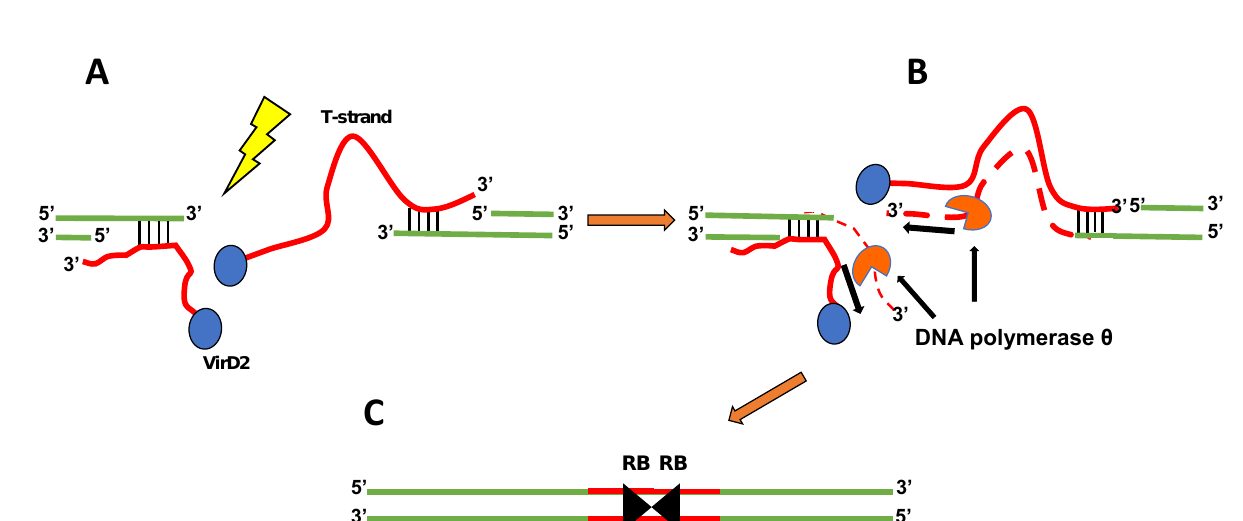
Figure 1. Model for the involvement of DNA polymerase θ in T-DNA integration. ( A ) Following generation of a double- strand DNA break (lightning bolt), the 5′ ends of plant DNA (green lines) are resected. Sequences within single-strand T- DNA molecules (T-strands, red lines), capped with VirD2 protein (blue oval) at their 5′ ends, align by microhomology with complementary regions of the exposed single-strand plant DNA. This can occur at both sides of the break (as pictured) or at one side only. ( B ) DNA polymerase θ (orange “pac - man” symbol) copies the T -strand sequence, using the exposed 3′ end of the plant DNA as a primer. The newly synthesized T-strand complementary sequence is ligated to the 5′ end of the break site, and the 5′ end of the T-strand is ligated to the 3′ end of the broken plant DNA following VirD2 removal. ( C ) Final result of integration of two T-DNA molecules in a head-to-head (RB-to-RB) orientation.